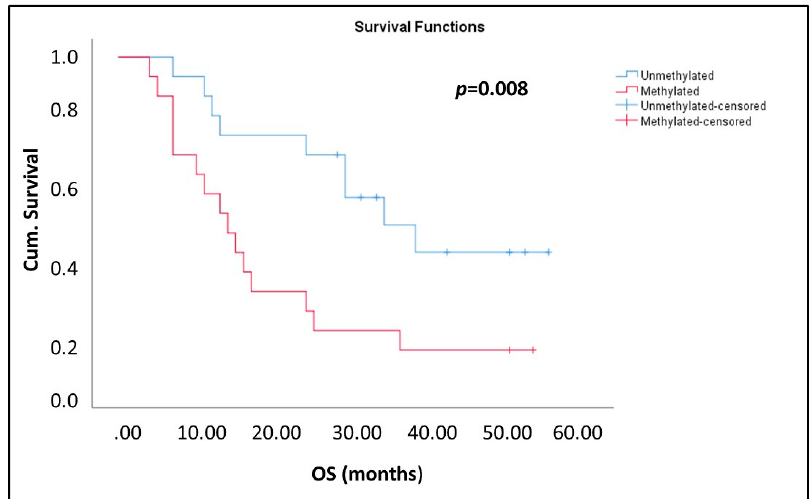
Figure 6. Kaplan–Meier estimates of patients with metastatic prostate cancer in relation to USP44 methylation in ctDNA ( n = 39).